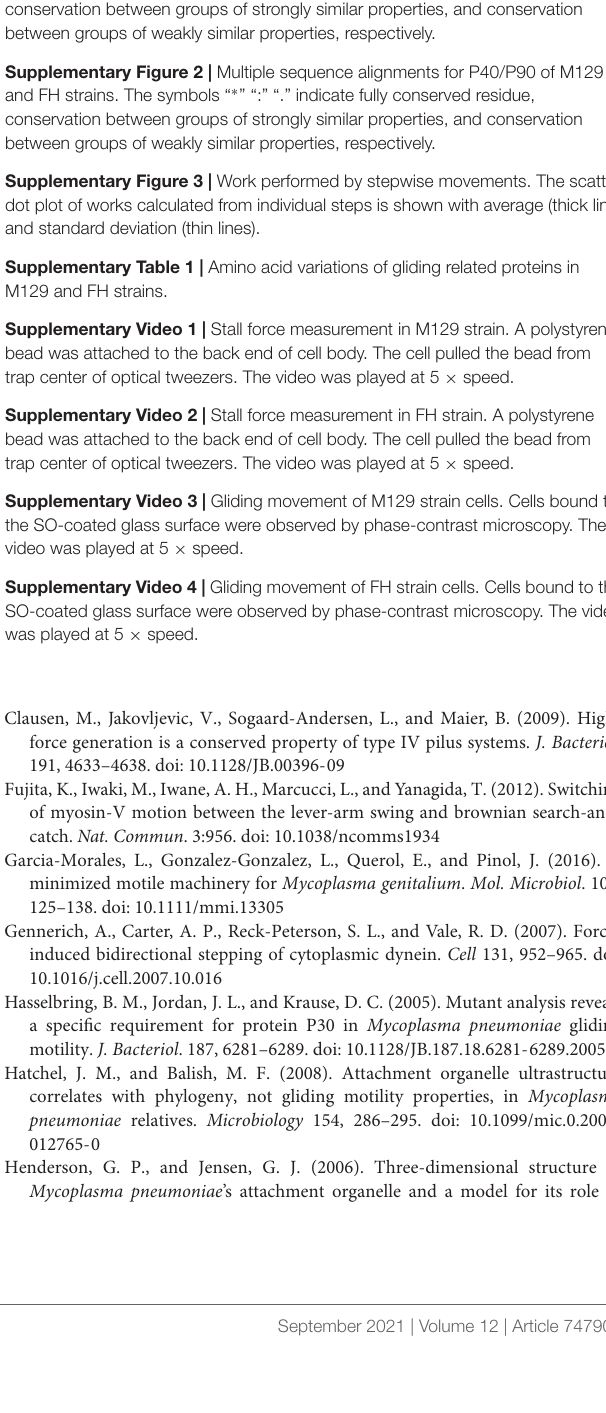
Supplementary Figure 1 | Multiple sequence alignments for P1 adhesin of M129 and FH strains. The symbols “ ∗ ” “:” “.” indicate fully conserved residue, conservation between groups of strongly similar properties, and conservation between groups of weakly similar properties, respectively. Supplementary Figure 2 | Multiple sequence alignments for P40/P90 of M129 and FH strains. The symbols “ ∗ ” “:” “.” indicate fully conserved residue, conservation between groups of strongly similar properties, and conservation between groups of weakly similar properties, respectively. Supplementary Figure 3 | Work performed by stepwise movements. The scatter dot plot of works calculated from individual steps is shown with average (thick line) and standard deviation (thin lines). Supplementary Table 1 | Amino acid variations of gliding related proteins in M129 and FH